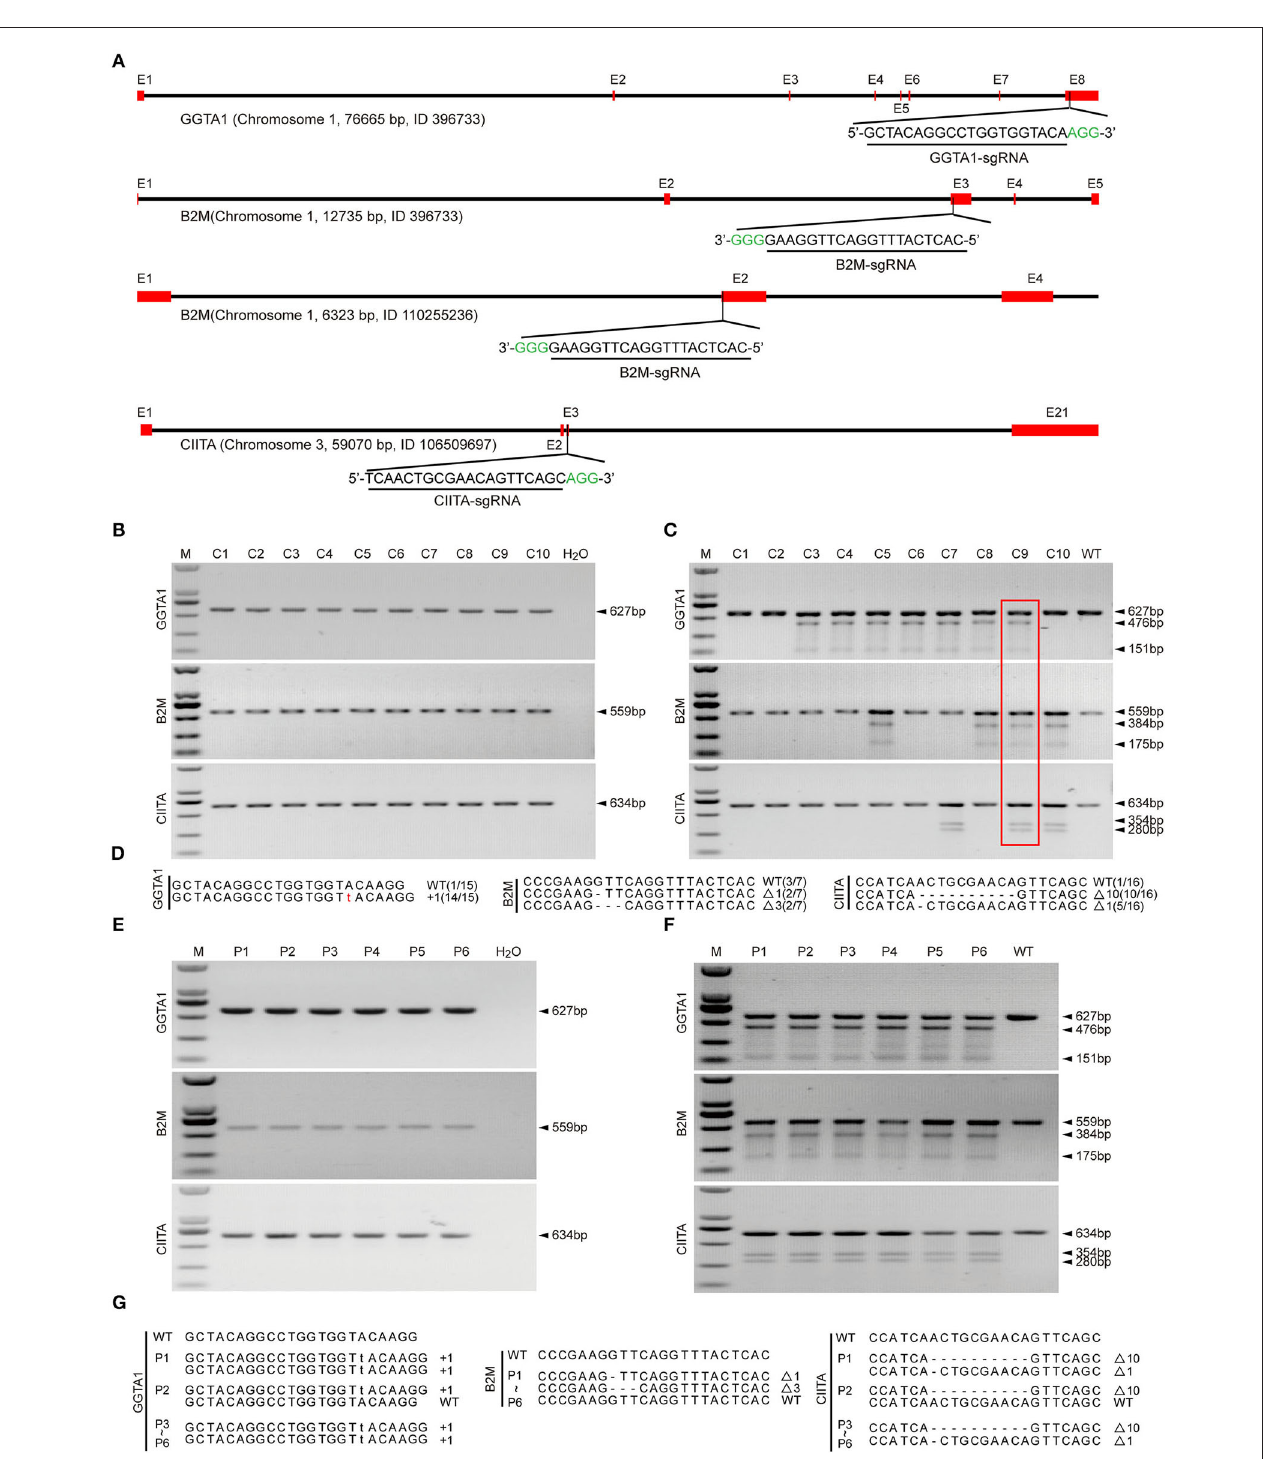
FIGURE 1 | Establishment of GBC-modified cell colonies and generation of GBC-modified pigs. (A) Schematic diagram of targeting to porcine GGTA1, B2M, and CIITA genes by the CRISPR/Cas9 system. (B) PCR products harboring the targeting regions of GGTA1, B2M, and CIITA genes from cell colonies (M, DNA maker DL2000; C, colony). (C) Identification of postive cell colonies by T7EI cleavage assay. The colony C9 is positive for triple-gene modification. (D) Genotypes of colony C9 by Sanger sequencing. (E) PCR products harboring the targeting regions of GGTA1, B2M, and CIITA genes from cloned pigs (P, pig). (F) Identification of cloned pigs by T7EI cleavage assay. (G) Genotypes of cloned pigs by Sanger sequencing.